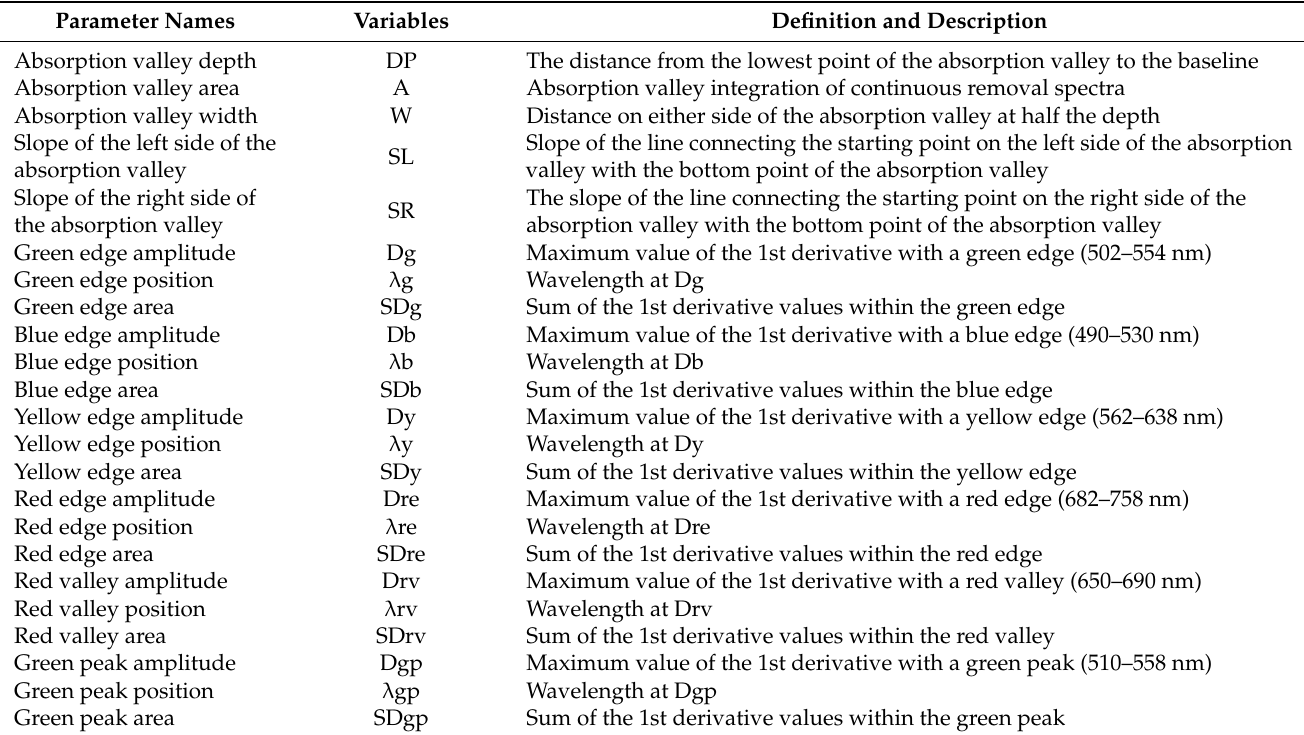
Figure 3. Potato canopy continuous removal spectra. V1 and V2 are two absorption valleys, DP1 is the first absorption depth, W2 is the second absorption width, A2 is the second absorption area, and SL2 and SR2 are the left and right slopes of the second absorption valley, respectively. Table 1. Spectral position characteristic parameters.